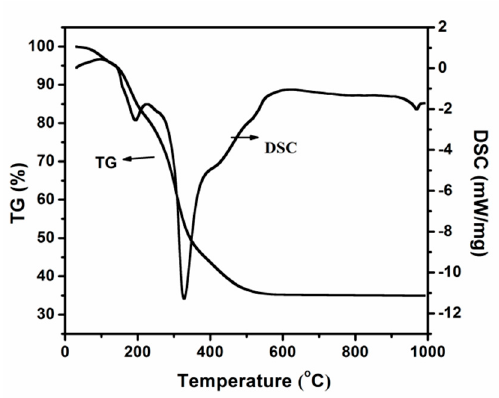
Figure 1. Thermogravimetric-differential scanning calorimeter (TG-DSC) curves of the obtained precursor when tetrabutyl titanate and ethanol are used as titanium source and solvent.